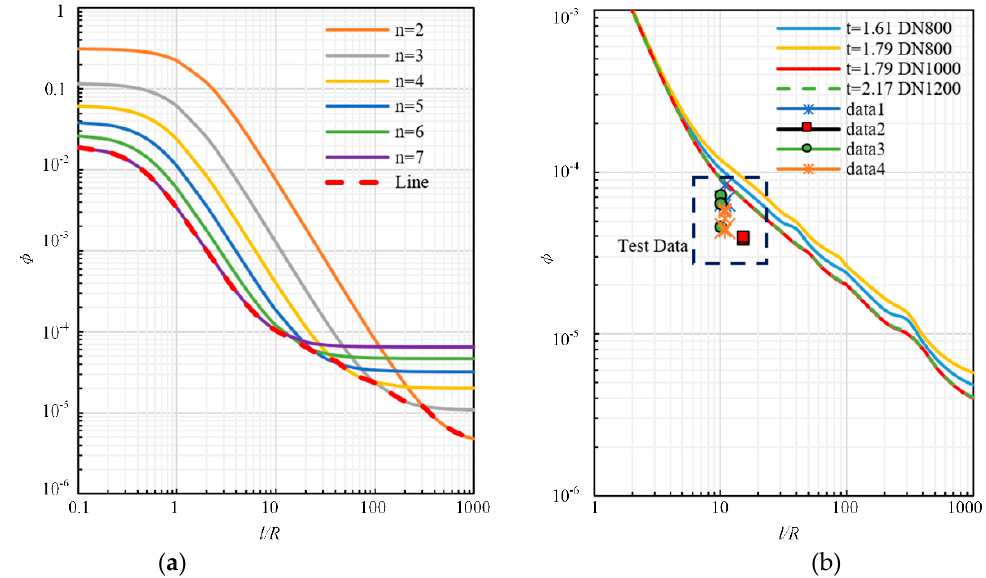
Table 3. Enhancement coefficient k under different buckling modes.